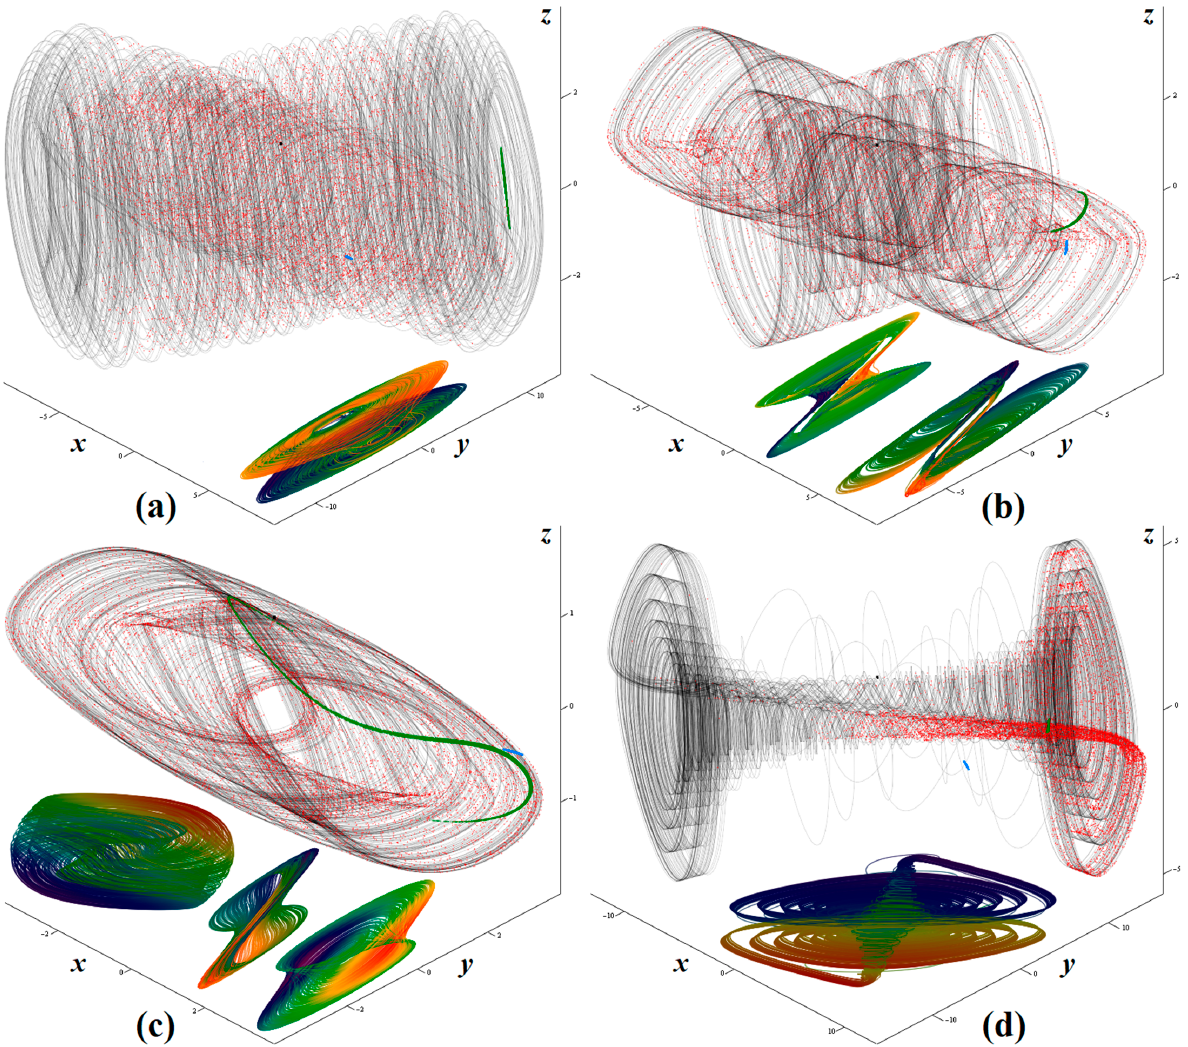
Figure 1. Selected numerical results associated with analyzed dynamical system (1): ( a ) z 11 = 1.1 Ω , z 12 = 1.5 Ω , z 22 = 1 Ω , β = 12 Ω , ( b ) z 11 = 1.1 Ω , z 12 = 1.3 Ω , z 22 = 1 Ω , β = 12 Ω , ( c ) z 11 = 1.2 Ω , z 12 = 1.3 Ω , z 22 = 1 Ω , β = 4 Ω , and ( d ) z 11 = 1.1 Ω , z 12 = 1.4 Ω , z 22 = 1 Ω , β = 18 Ω . Subplot shows zoomed group of randomly generated initial conditions with uniform distribution.